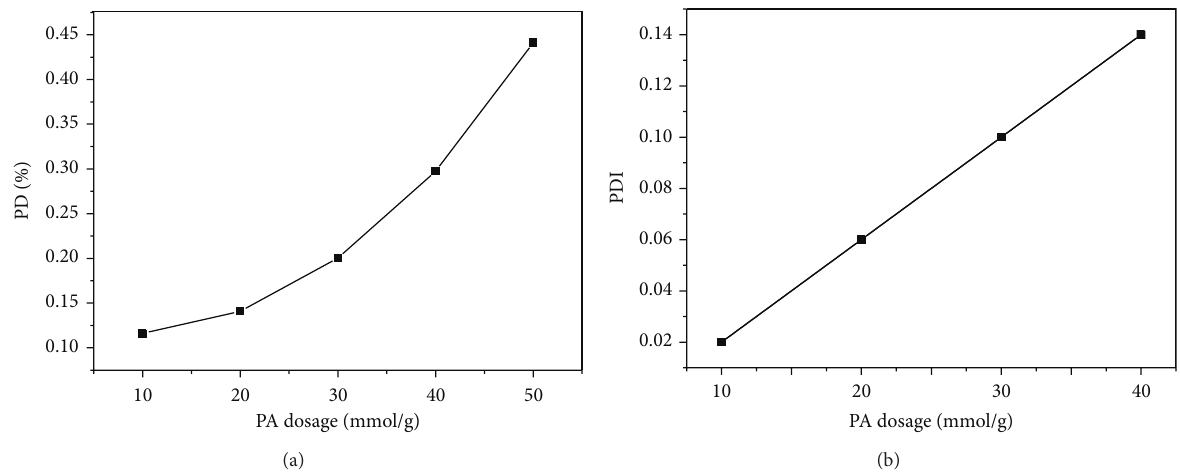
Figure 1: Dependence of phthalation degree ((PD), (a)) and phthalation degree increase ((PDI), (b)) on phthalic anhydride dosage.